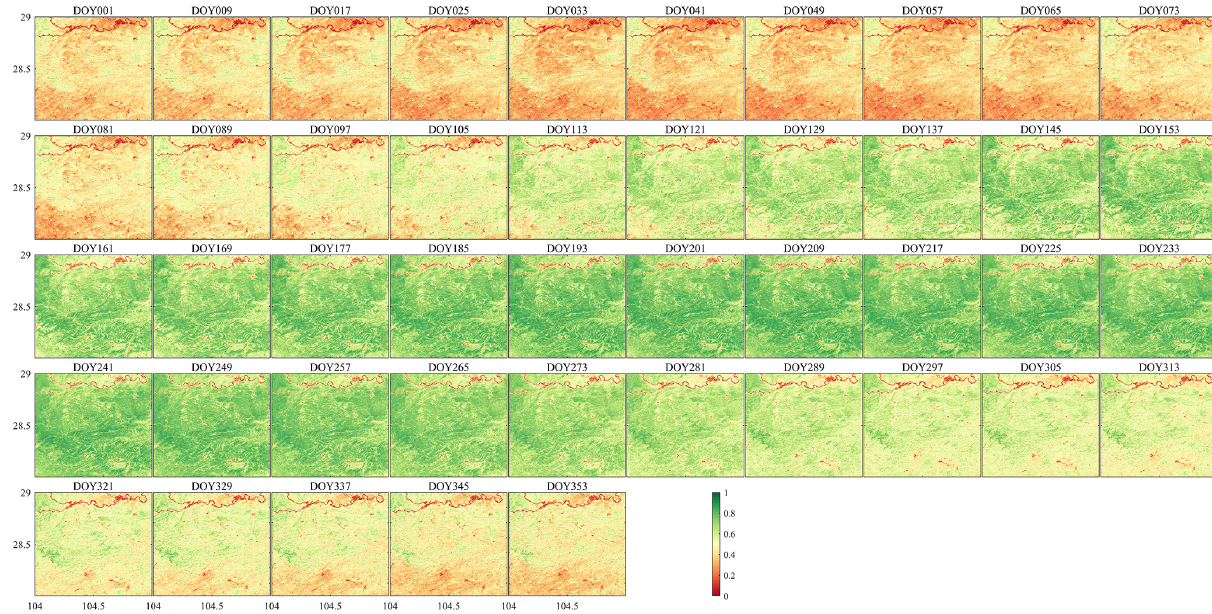
Figure 11. GLASS V6 time series of FAPARs in a 1 ◦ × 1 ◦ region in southwestern China in 2021. The spatial resolution is 250m latitude and